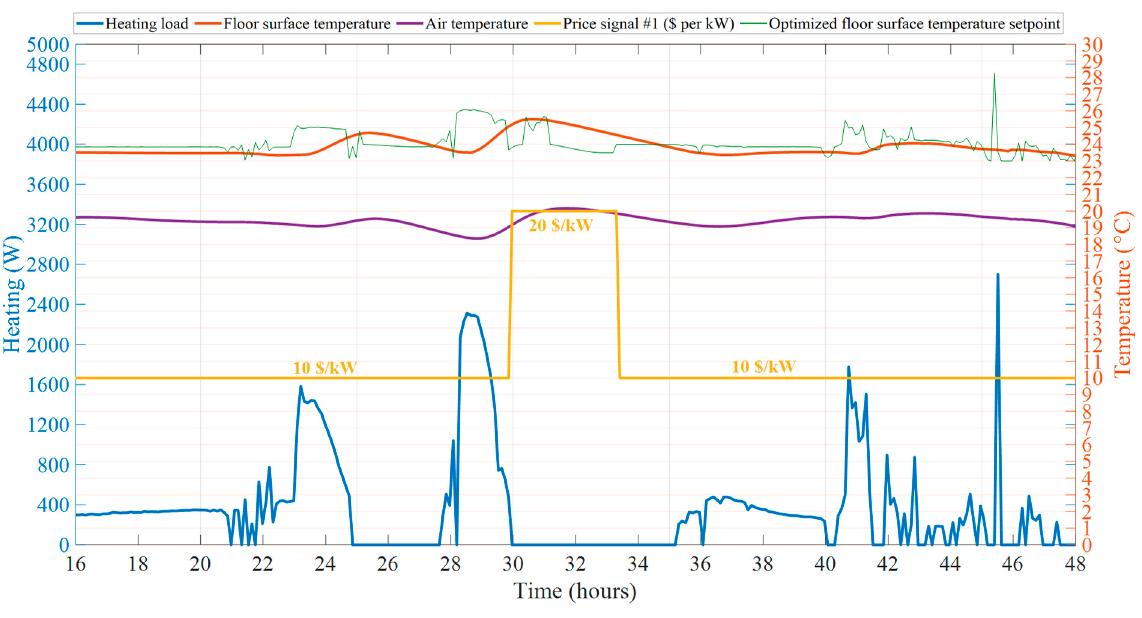
Figure 13. Predictive strategy for price signal #1.